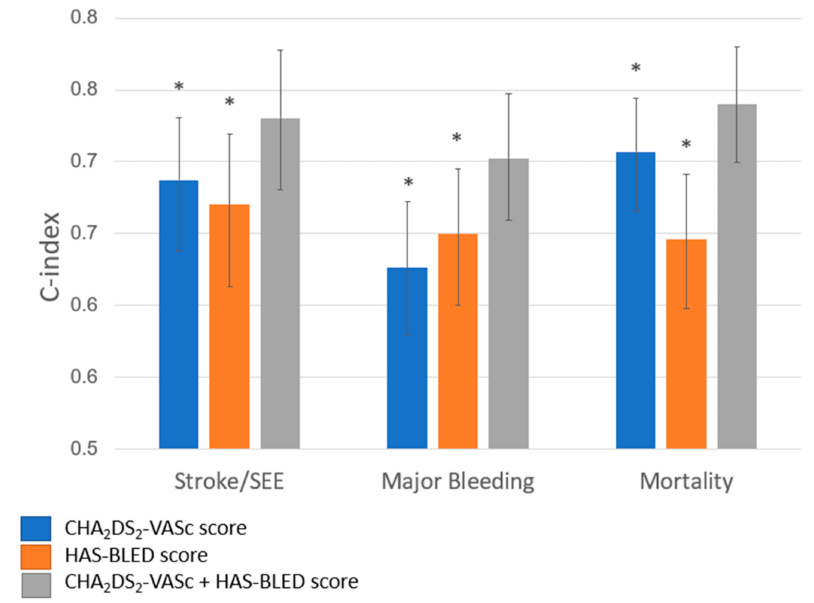
Figure 3. C-index of logistic models by outcome and predictor items risk scores; * denotes a C-index of the specific score significantly di ff erent ( p -value < 0.05) from C-index of the combined